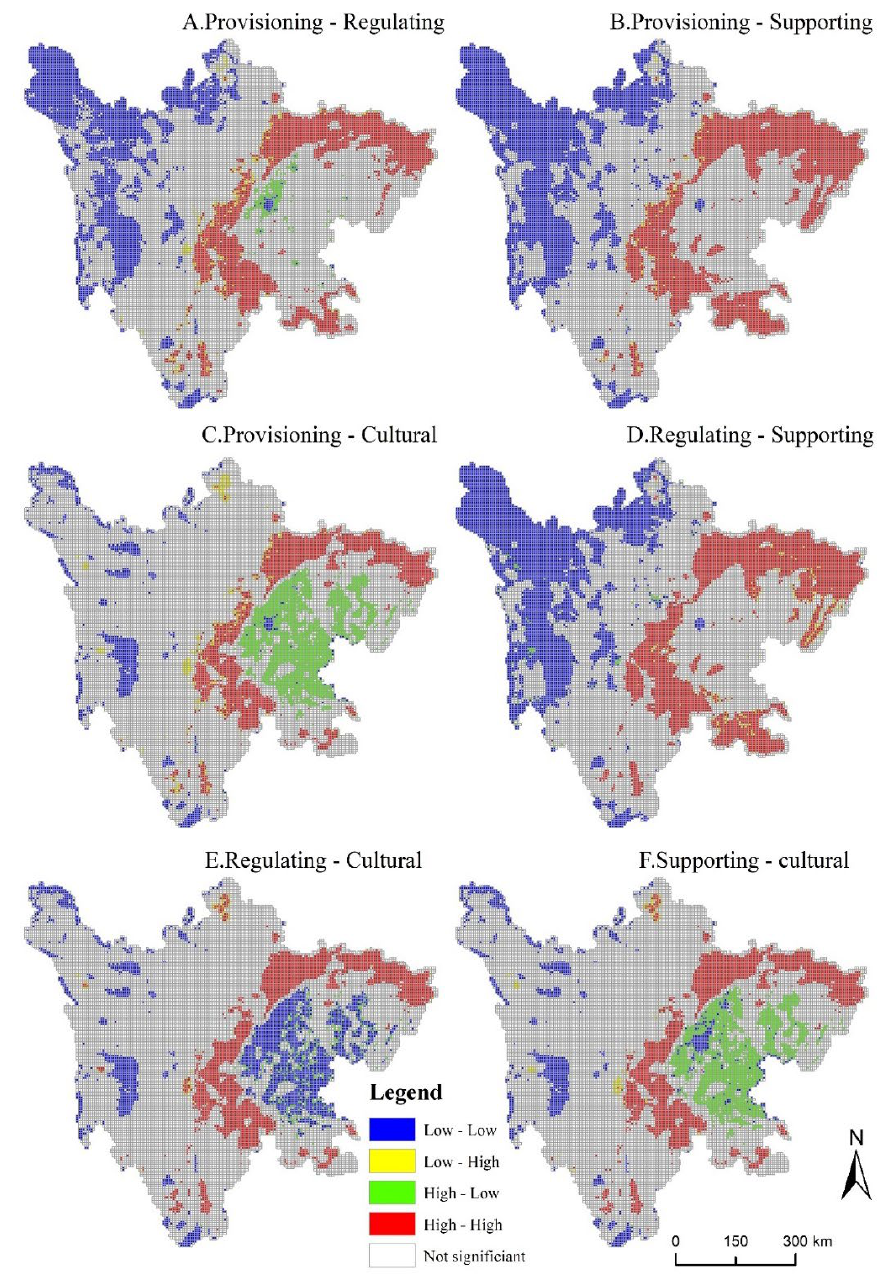
Figure 6. LISA cluster map of 4vecosystem services in Sichuan Province at grid-scale.